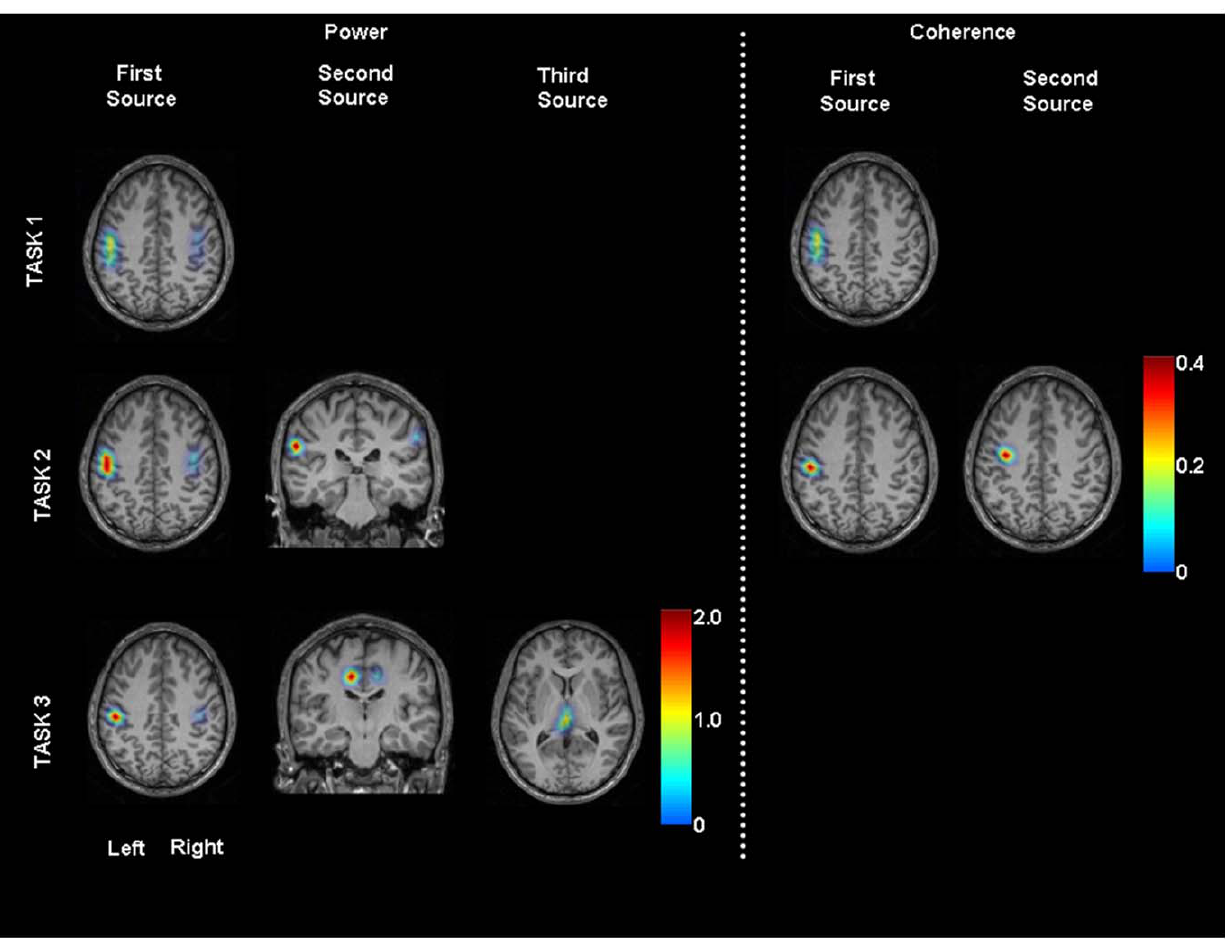
Figure 2. Source analysis of Post-Movement Beta Synchronization and Cortico-muscular Coherence (grand average data). In Task1 high beta power and strong CMC could be detected in the primary sensorimotor cortex. In Task2 the strongest sources could be presented in the same area, but second source of PMBS was estimated in the secondary sensory cortex, second source of CMC in the premotor cortex. Sources of PMBS were bilateral; sources of CMC were unilateral in Task1-2. In Task3 source of PMBS in the primary sensorimotor and supplementary motor area were bilateral and we could detect additional source in the thalamus.